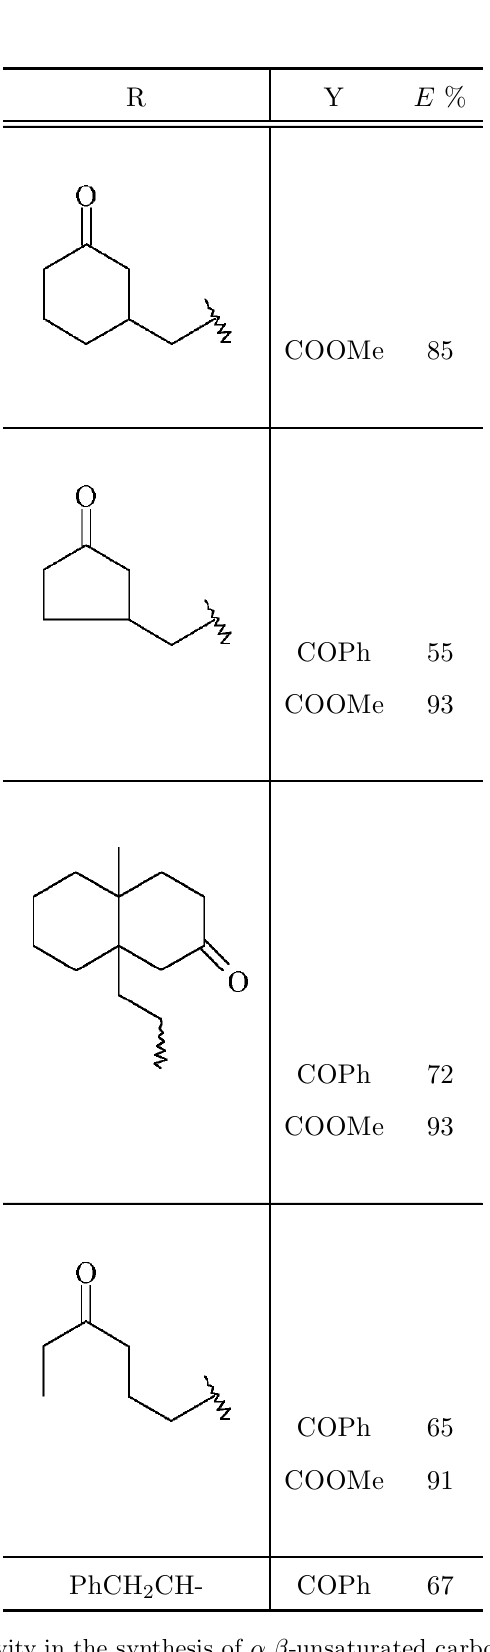
Table 2 The stereselectivity in the synthesis of ¬ , › -unsaturated carbonyl compounds from the reaction of the monosubstituted ozonides and stabilized phosphorus